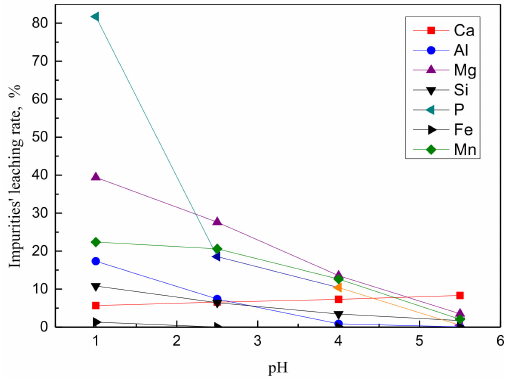
Figure 5. Effect of pH on the vanadium leaching rate (particle size of 75–96 µ m, time of 60 min, T = 65 ◦ C, L / S = 4, stirring speed of 500 rpm).